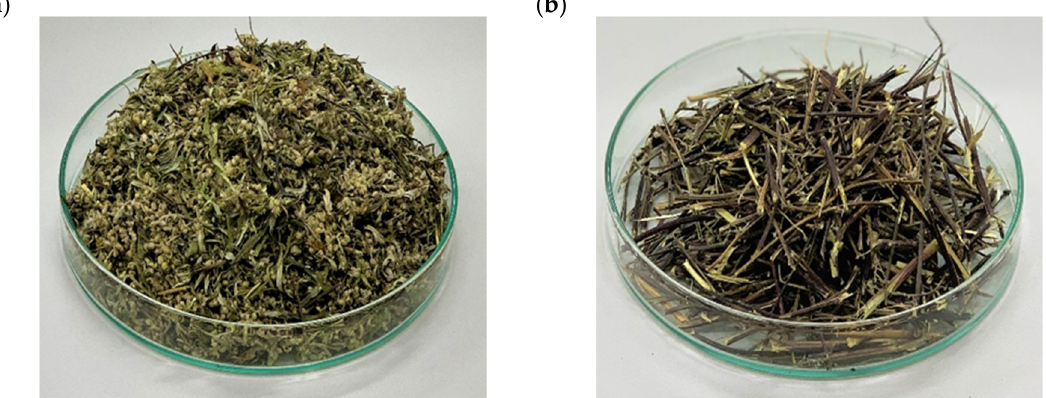
Figure 8. Precursor of biochars and activated biocarbons–a post-extraction residue obtained from the mugwort inflorescences/leaves ( a ) and mugwort stems ( b ).